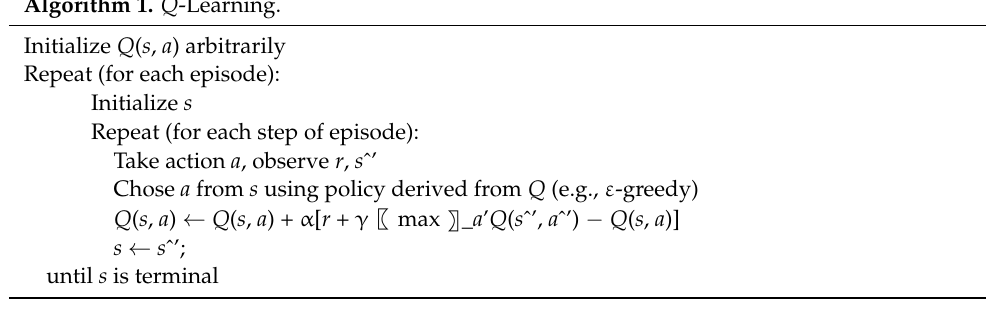
Algorithm 1 . Q -Learning. Algorithm 1 . Q Algorithm 1. Q -Learning.